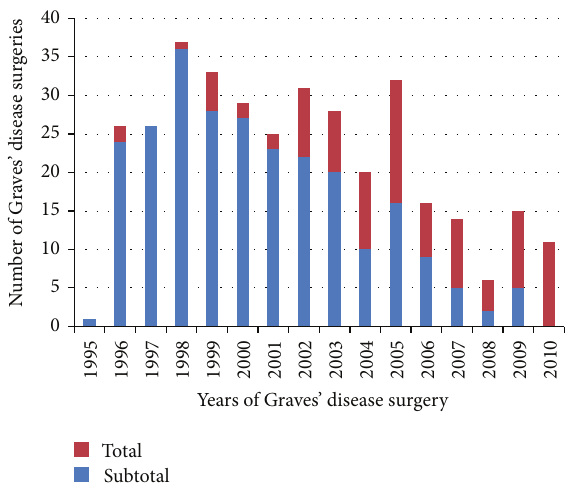
Figure 1: Changes in surgical method selected in Graves’ disease requiring